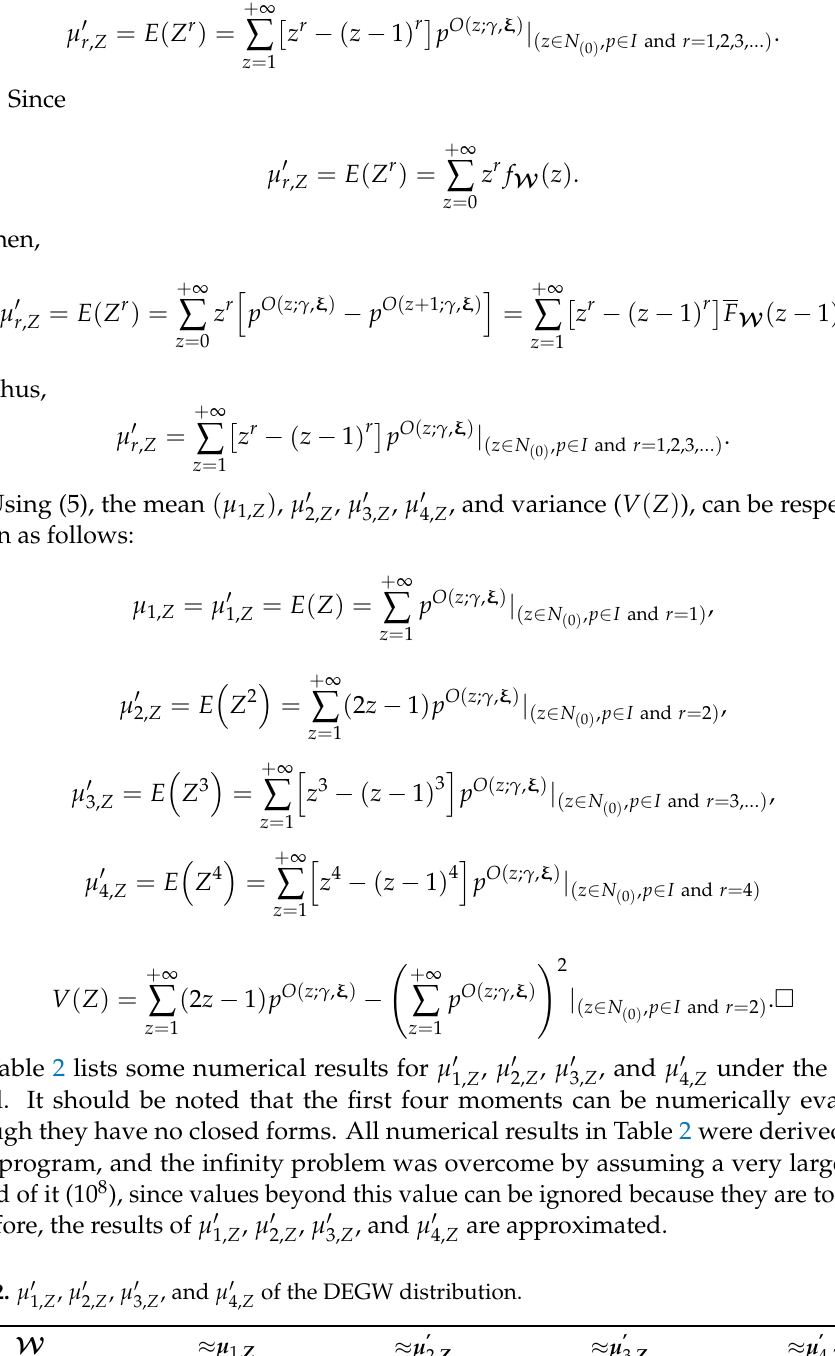
Table 2. µ (cid:48) , µ (cid:48) , µ (cid:48) , and µ (cid:48) of the DEGW distribution. 2, Z 3, Z 1, Z 4, Z W ≈ µ ≈ µ ’ ≈ µ ’ ≈ µ ’ 1 , Z 2 , Z 3 , Z 4 , Z (0.10, 1.0, 1.0) 0.0191306 0.0191314 0.019133 0.0191363 (0.50, 1.0, 1.0) 0.3158439 0.3397145 0.387467 0.4830028 (0.99, 1.0, 1.0) 3.5744810 14.246690 60.28199 266.46120 (0.10, 0.5, 1.5) 0.2253027